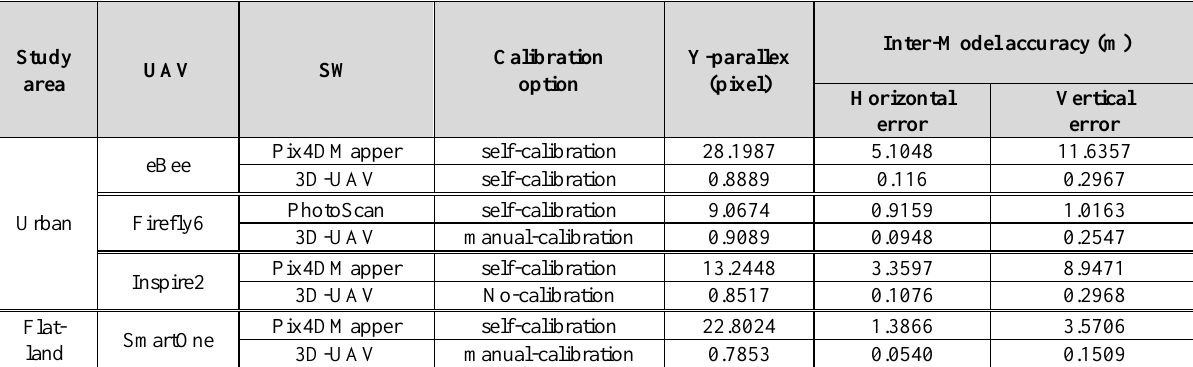
Table 4. Y-parallex and inter-model accuracy